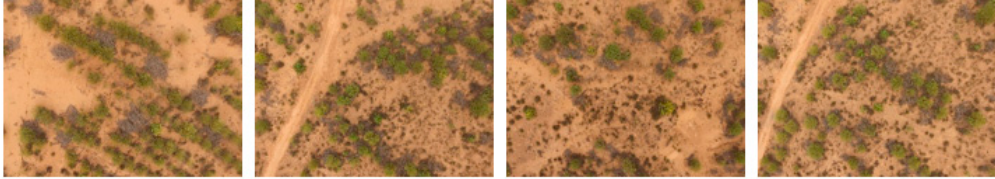
Figure 2. Unmanned aerial vehicle (UAV) image data. Table 1. UAV image data parameter information.